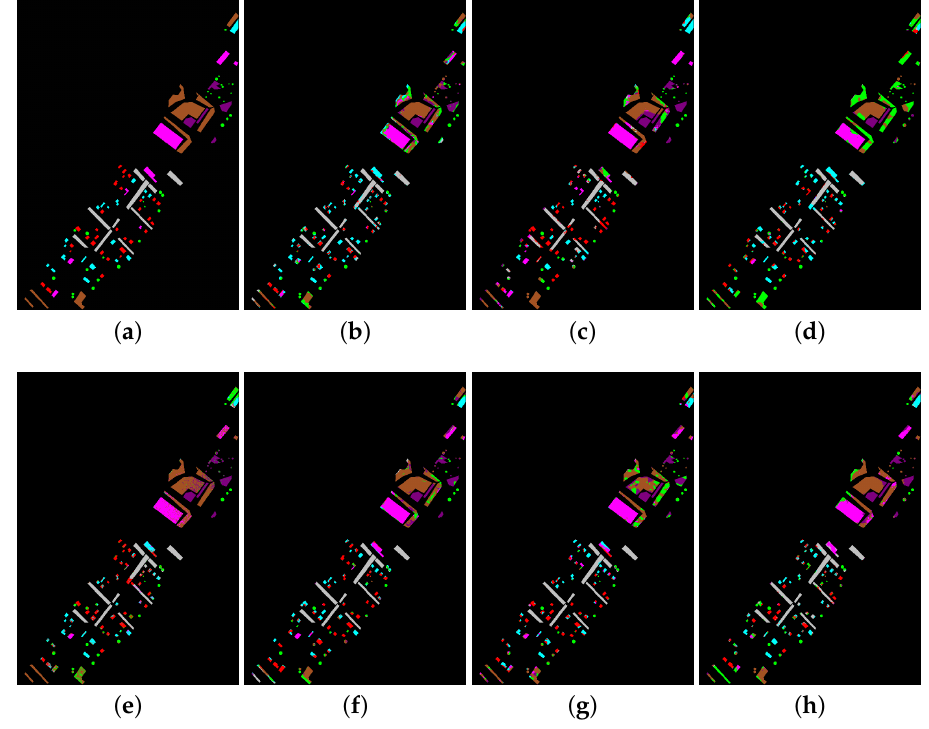
Figure 6. Classification maps by compared methods for GRSS_DFC_2014 data set. ( a ) the ground